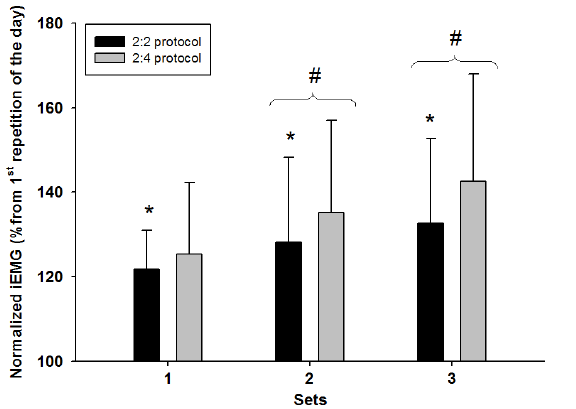
Figure 1. Mean normalized iEMG of the pectoralis major muscle for each training protocol (values normalized using the 1st repetition of the day).